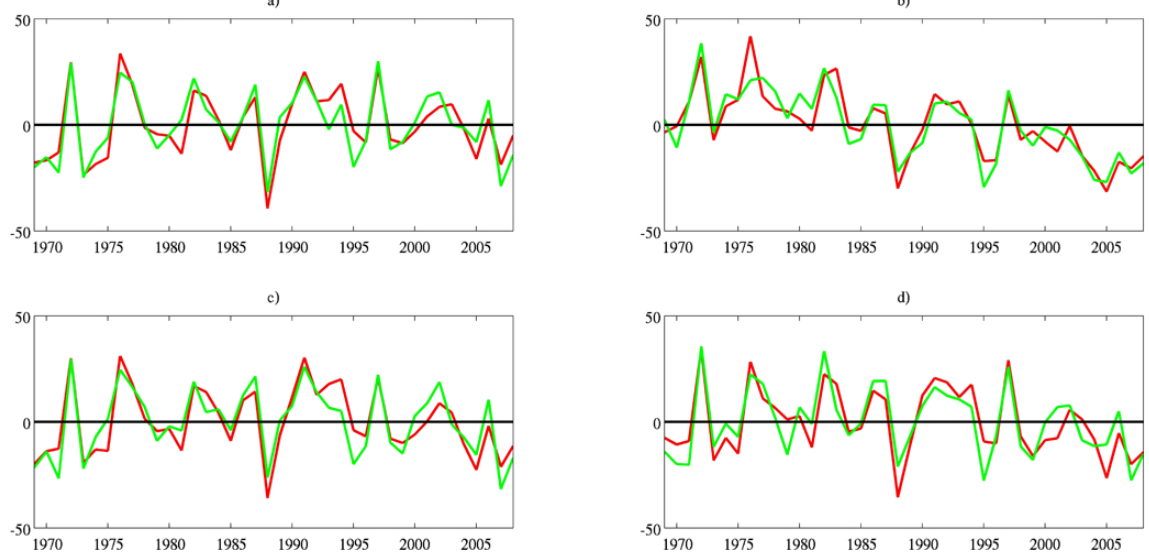
Fig. 6. Normalized time series for mode 1, from 1969 to 2008. (a) ACM, (b) FRD, (c) p80, and (d) p10. Red lines are for July SST modes and green lines are for ASO precipitation modes. Canonical correlation of this mode in all the variables was around 0.9 with statistical significance above 99% ( α < 1%), according to Davis (1976).